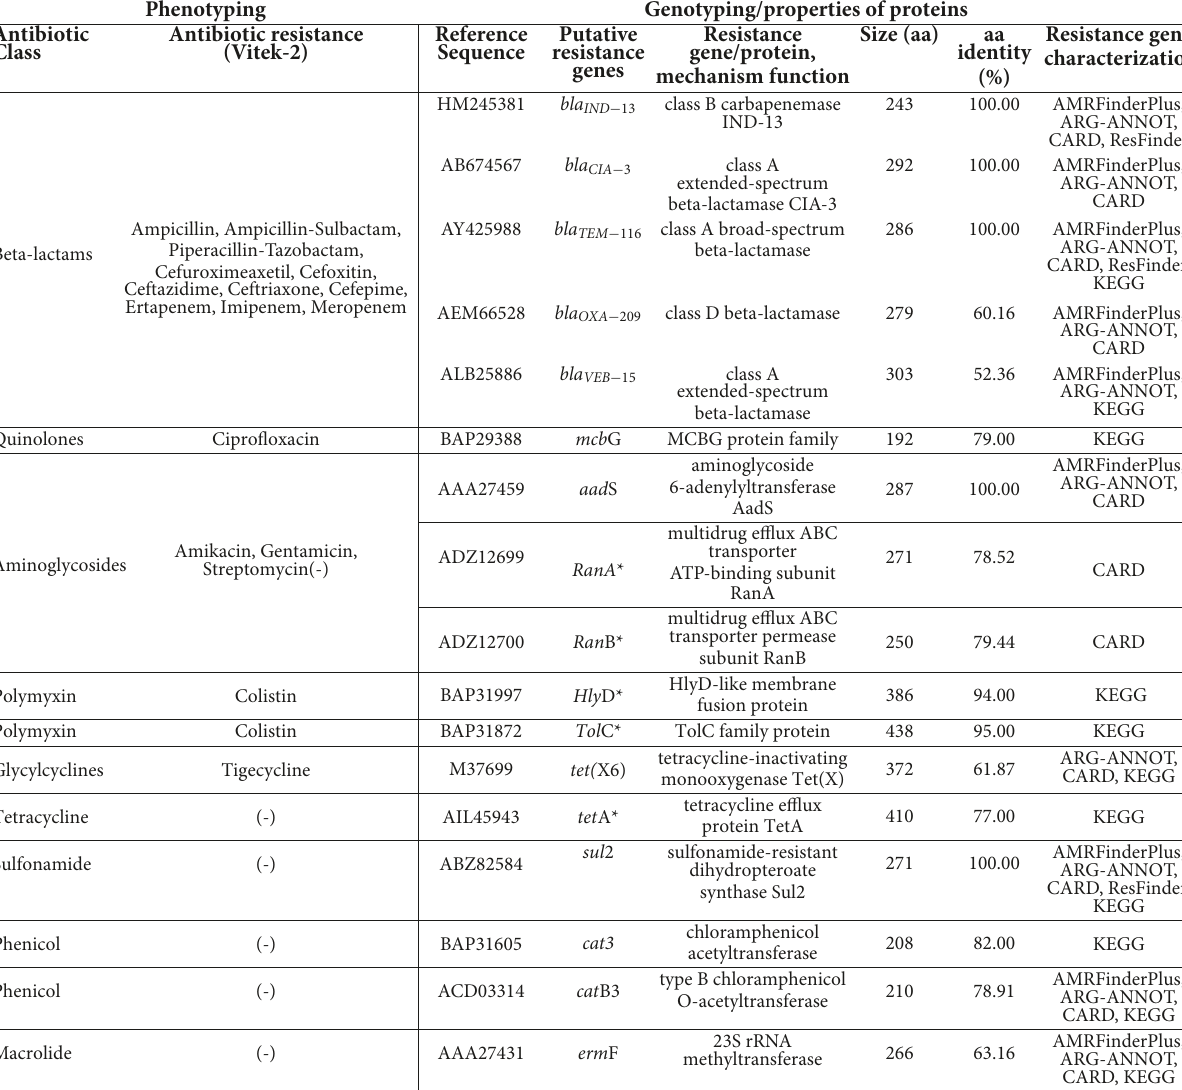
TABLE 1 Phenotyping and antibiotic resistance genes found within the Chryseobacterium indologenes